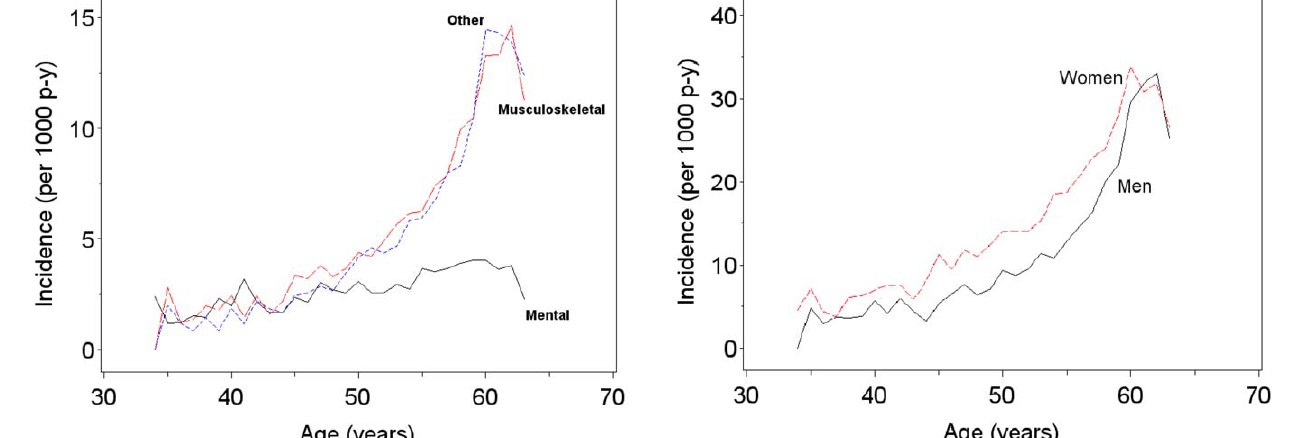
DP diagnoses Men (same-sex